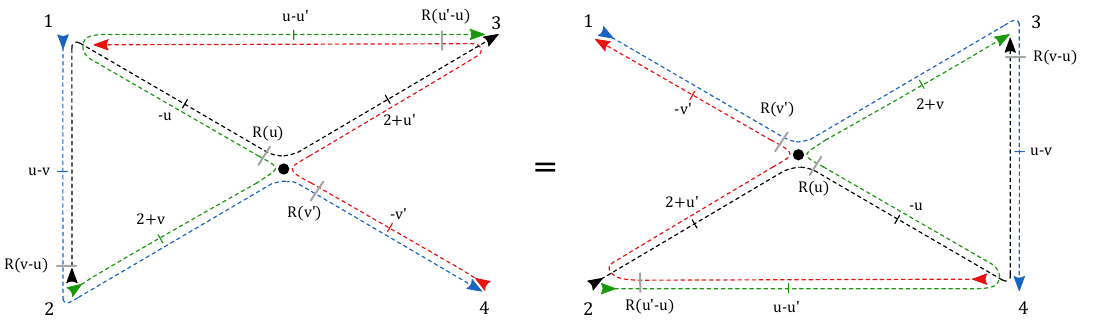
Figure 9 . Diagrammatic form of the interchange relation